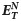
Stokes shift variation with the normalized value of solvent polarity ETN for SAL-3.Black square–I Stokes Shift, red circle–II stokes shift in different solvents (1—n-hexane, 2—n-heptane, 3 –chloroform, 4—DMF, 5—DMSO, 6—acetonitrile, 7 –propan-2-ol, 8 –butan-1-ol, 9—ethanol, 10 –methanol, 11—H2O).